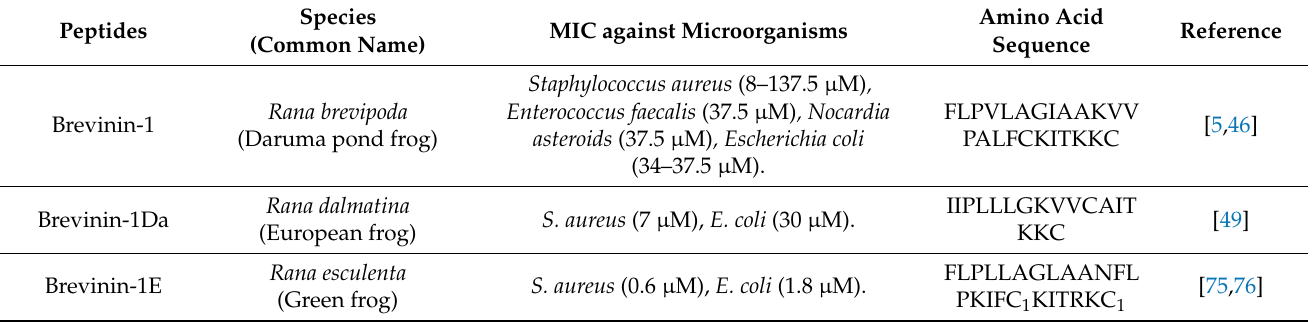
Figure 2. Mechanisms of action of antimicrobial peptides (the peptides are shown as cylinder rods, where the hydrophilic regions are presented in red color and the hydrophobic regions in blue). ( a ) Aggregate model; ( b ) toroidal pore model; ( c ) barrel-stave model; ( d ) carpet model. Adapted with permission from ref. [70]. Copyright © 2023 American Society for Microbiology. Table 3. Representative antimicrobial peptides (AMPs) isolated from various species of amphibians.